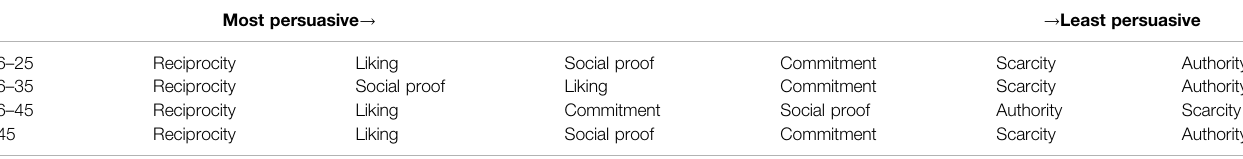
TABLE 5 | Persuasion pro fi les based on age.